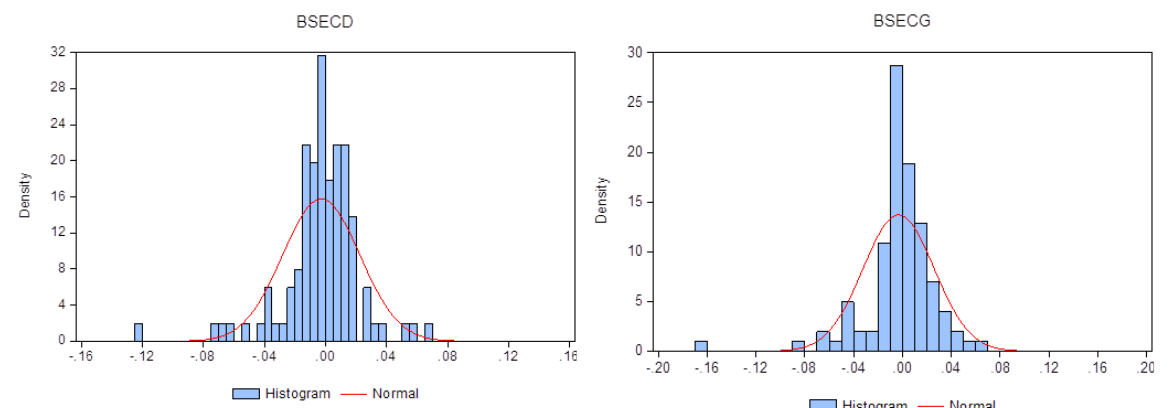
Figure 1 (cont.). Frequency and normal distribution of stock returns during the crisis